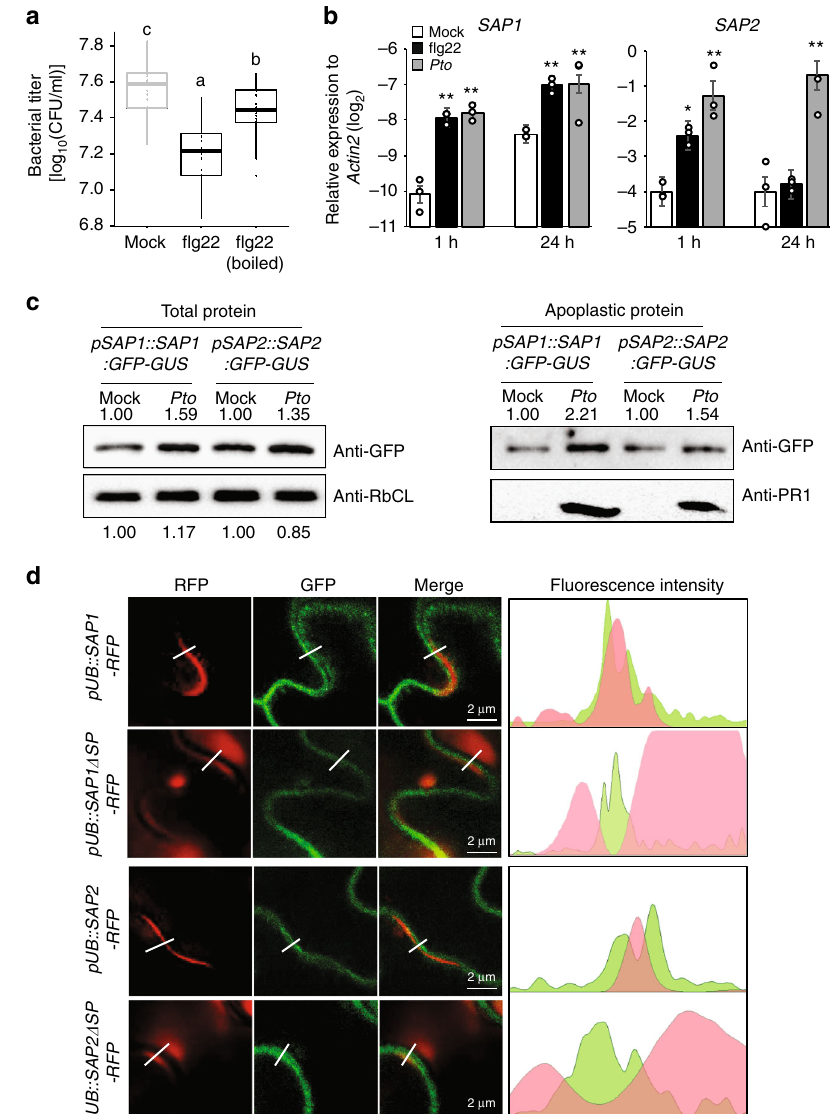
Fig. 1 Secreted aspartic protease 1 (SAP1) and SAP2 are induced and secreted during P. syringae infection. a In vitro growth of Pto (OD 600 = 0.05) amended with apoplastic fl uid from leaves of -week-old Col plants at 24 h post in fi ltration (hpi) with 1 µ M fl g22 or mock or boiled apoplastic fl uid (boiled) was measured at 9 h after culturing. Bars represent means and s.e.m. of three independent experiments each with eight replicates. Statistically signi fi cant differences are indicated by different letters (adjusted P < 0.05). b Expression of SAP1 and SAP2 in leaves of 4-week-old Col plants at 1 or 24 hpi with mock, 1 µ M fl g22, or Pto (OD 600 = 0.001). Bars represent means and s.e.m. of three biological replicates. Asterisks indicate signi fi cant differences (Student ’ s two- tailed t test; * P < 0.05, ** P < 0.01). c Accumulation of SAP1-GFP (green fl uorescent protein) and SAP2-GFP at 1 day post in fi ltration (dpi) with Pto (OD 600